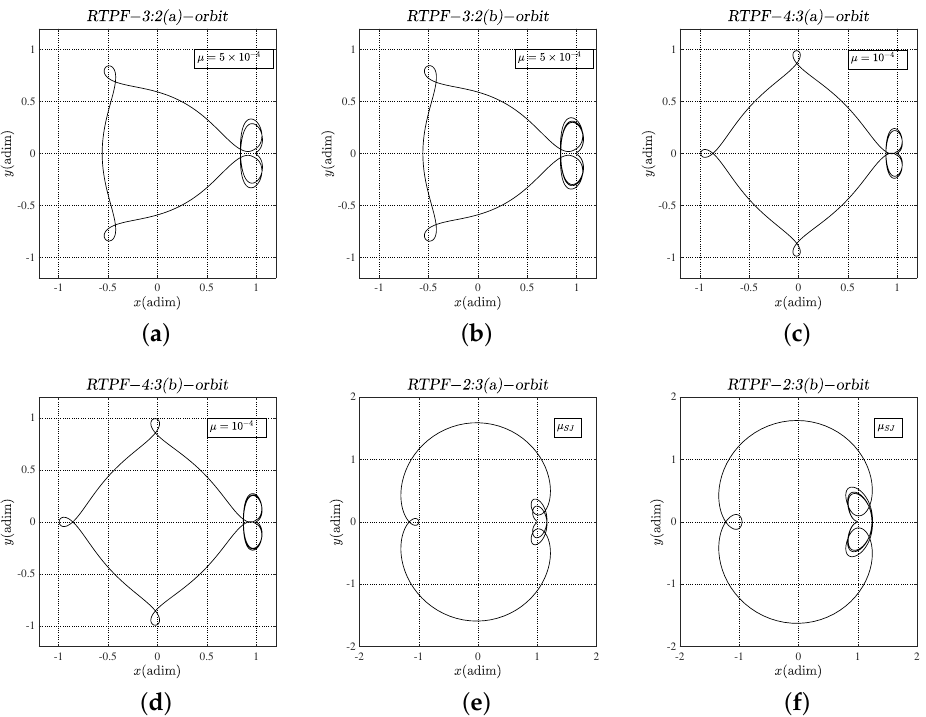
Figure 11. ( a ) Example orbit in RTPF-3:2(a) ; ( b ) Example orbit in RTPF-3:2(b) ; ( c ) Example orbit in